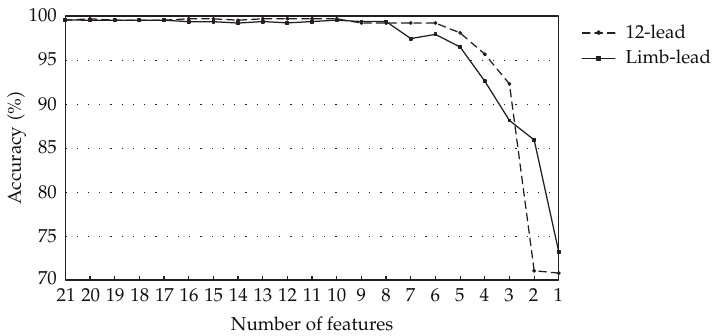
Figure 4: Comparison of classification performances between the method using a standard 12-lead system and our proposed method using the limb-lead